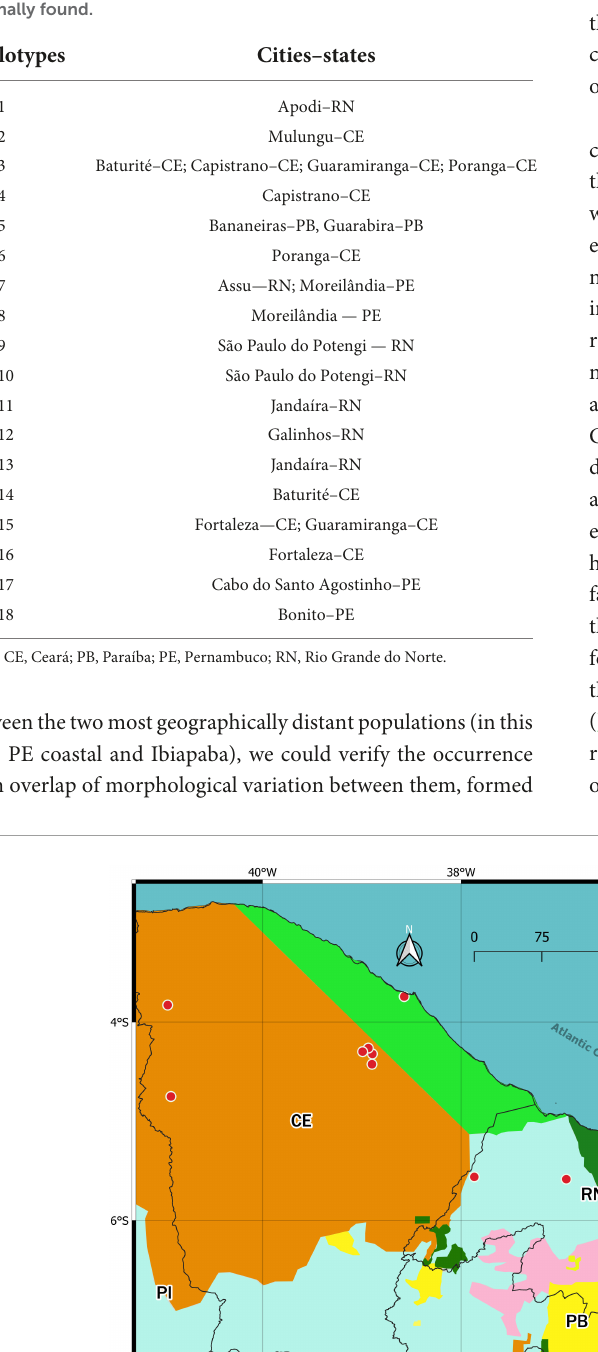
Frontiers in Ecology and